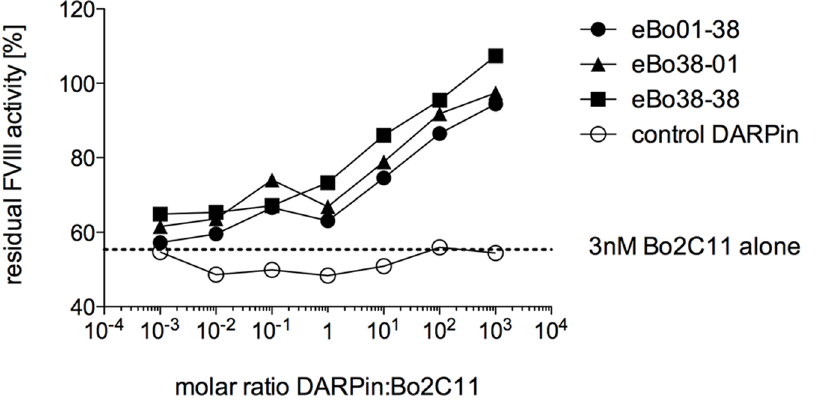
Figure 5. Anti-Bo2C11 DARPins neutralize inhibitory activity of Bo2C11. Different concentrations of three dimeric DARPins recognizing the monoclonal anti-FVIII antibody Bo2C11 (eBo01-38: closed circles; eBo38-01: closed triangles; eBo38-38: closed squares) or a dimeric control DARPin (open circles) were mixed 1:1 with 6 nM of Bo2C1, added to human standard plasma and analyzed in the modified Bethesda assay. 3 nM of the monoclonal anti-FVIII antibody Bo2C11 corresponded to 1 Bethesda Unit (BU) (dotted line). Values were normalized to standard plasma and expressed as residual FVIII activity.